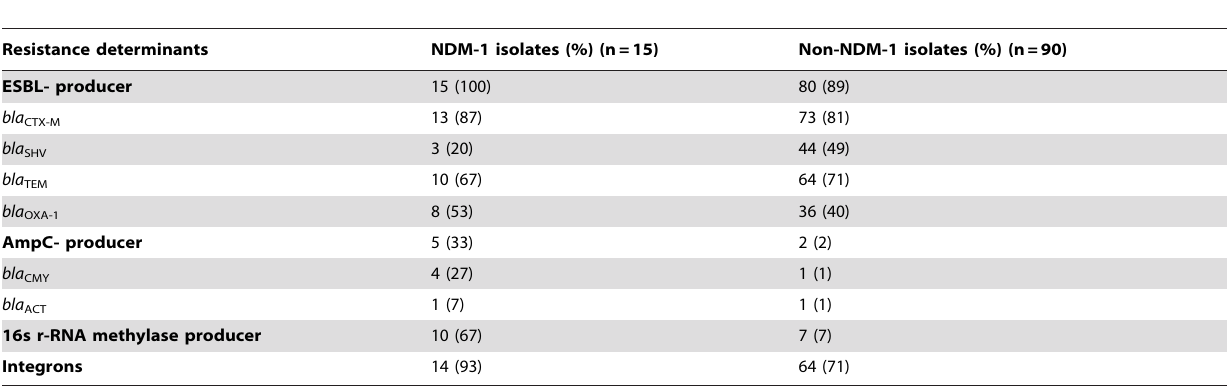
Table 5. Comparison of the presence of resistance determinants and integrons between NDM-1- producing and non-producing Enterobacteriaceae isolates.